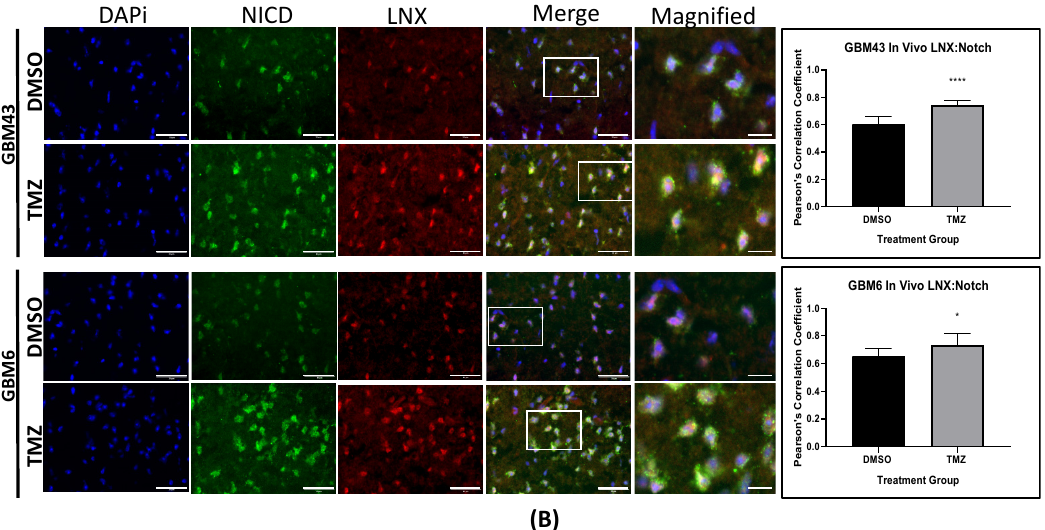
Figure 4. LNX–Numb and Numb–Notch1 interactions were upregulated after TMZ therapy. ( A ) An intraperitoneal (IP) injection was performed for LNX1 in GBM6 and GBM43 cells. Samples were then probed for Numb and Ubiquitin. An increase in Numb–LNX interactions and an increase in LNX–Ubiquitin interactions were noted after TMZ therapy, compared to the DMSO control. An additional IP injection was performed for Notch1 and samples were probed for Numb and ubiquitin levels. A mild increase was noted for Notch1–Numb interactions. IgG controls were performed for all IP injections. ( B ) GBM43 and GBM6 cells were implanted in mice, following our mouse model for intracranial tumors. Tissue samples were isolated from these mice were then stained for LNX1 and Notch1 expression. The tumor area was imaged and colocalization analysis was performed for LNX1 and Notch1 expression. Results showed that LNX1 and NICD colocalization was significantly elevated after TMZ therapy. Image analysis was performed in ImageJ, using the coloc2 package. Statistical analysis was performed in Prism 8, using the Student’s t-test to compare 2 groups and calculate significance. * p < 0.05; **** p < 0.0001 Scale bars correspond to 50 µ M on DAPi, NICD, LNX, and merge image panels and 10 µ M on the magnified